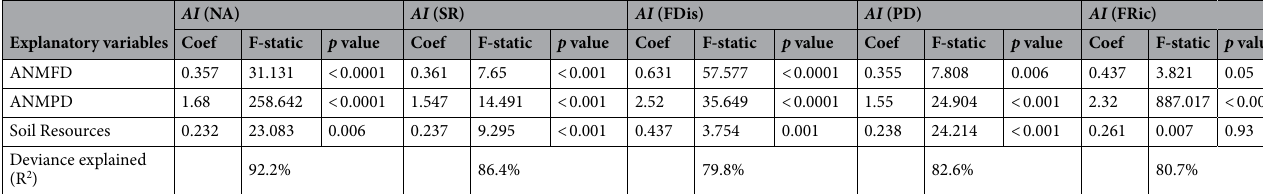
Table 2. F-static, coefficients (Coef), and p-values predicted by GAM models that test the effects of soil resources (soil moisture—organic matter-nitrogen) represented by their PCA scores and the alien functional and phylogenetic relatedness to natives (ANMFD, ANMPD respectively) on alien impact ( AI ). Response variables are represented by AI on native abundance (NA), native species richness (SR), native functional diversity (FDis), Native Phylogenetic Diversity (PD) and Functional Richness (FRic); Note: AI was calculated as a ratio between the difference in the native diversity (between invaded plots and non-invaded plots), and the sum of native diversity of both plots type (see “Methods” section).